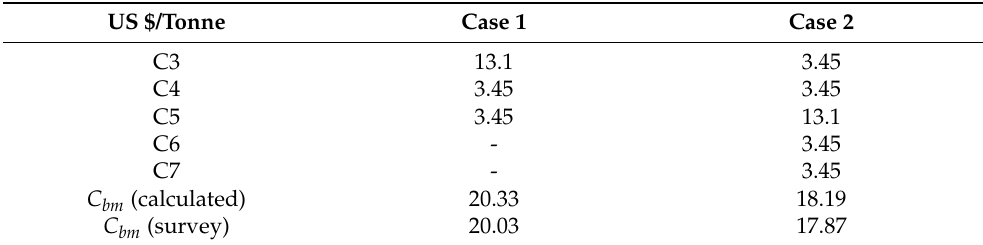
Table 2. MATLAB simulation results of C bm stage for Case 1 and Case 2.